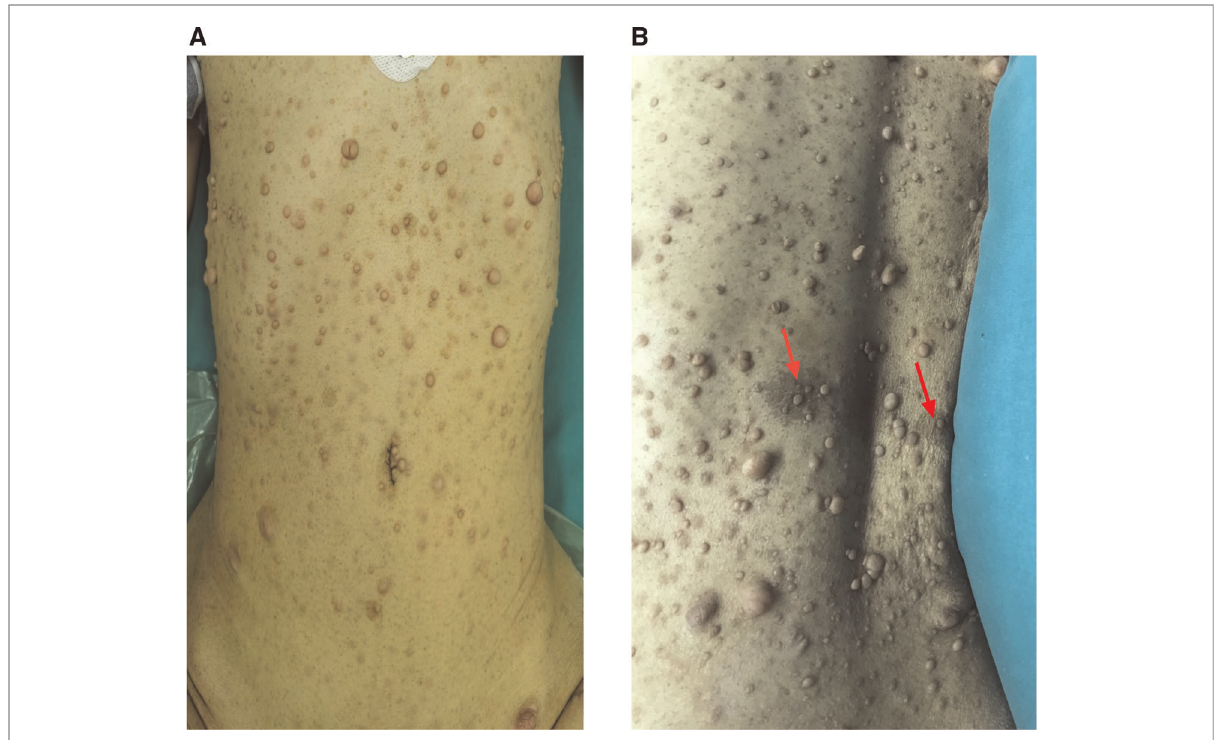
FIGURE 1 Individuals who have neuro fi bromatosis type 1 NF1 may exhibit a variety of cutaneous characteristics, including ( A ), the growth of nerve sheath tumors (neuro fi bromas)is a prominent hallmark of NF1. Neuro fi bromas can develop as isolated nodules or as cutaneous neuro fi bromas ( B ). pigmentary feature of NF1 patient (café-au-lait macules) on the back of the patient as